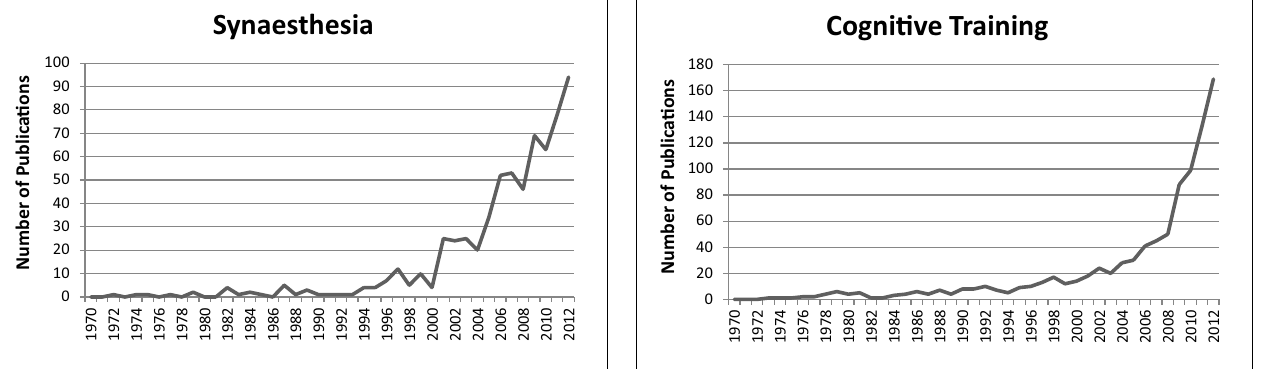
FIGURE 2 | Number of publications per year in the scientific field of cognitive training. The figure represents the hits for the search term “cognitive training” in the title, abstract, or keywords. Source: Scopus